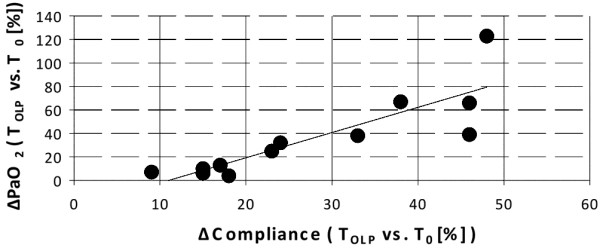
Correlation graph of percentage difference of dynamic compliance and percentage change in PaO2 from T0 to TOLP. P < 0.05, r = 0.62. PaO2 = partial pressure of arterial oxygen; T0 = time at baseline; T20/30 = time when positive end-expiratory pressure at 20 cmH2O and driving pressure at 30 cmH2O.